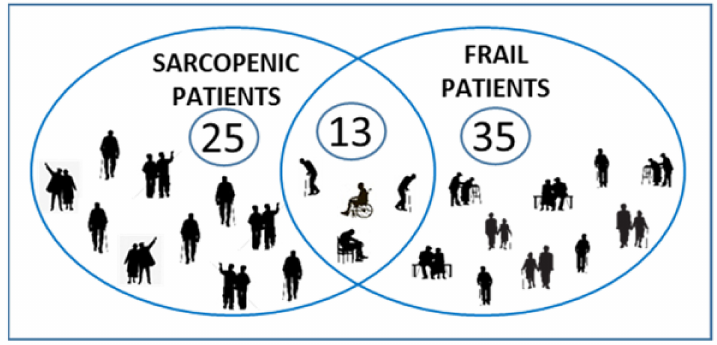
Figure 2. Prevalence of frailty and sarcopenia in the study sample.